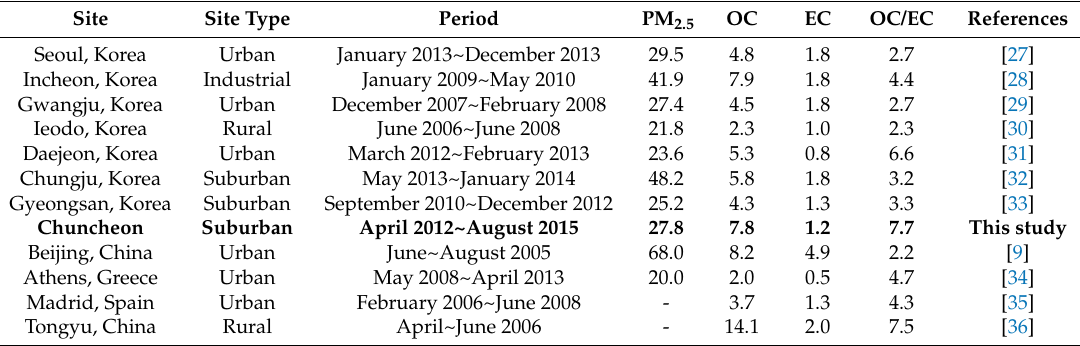
Table 4. Comparisons of measured concentrations of PM 2.5 and its carbonaceous compounds with those reported in other studies. Units of PM2.5, OC, and EC are µ g m − 3 . Site Site Type Period PM 2.5 OC